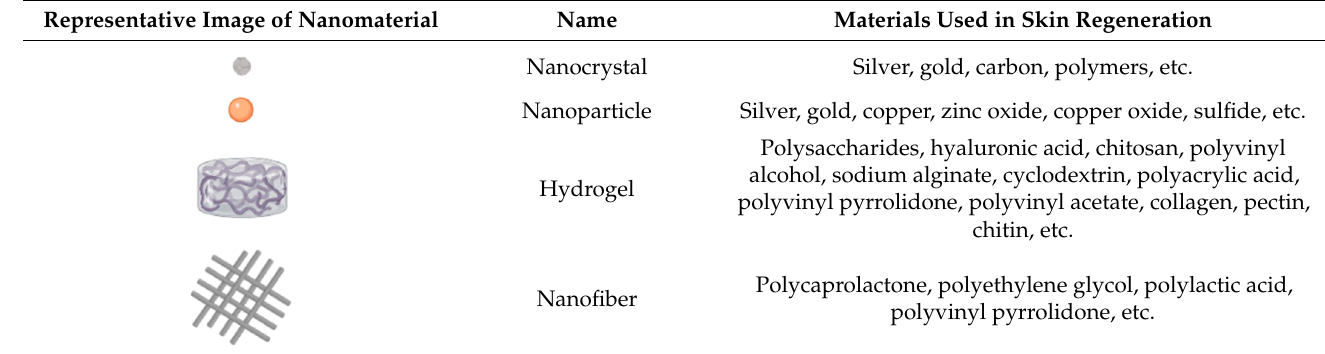
Table 1. Illustration of the structure and the materials mainly used in the field of skin regeneration and rejuvenation. Representative Image of Nanomaterial